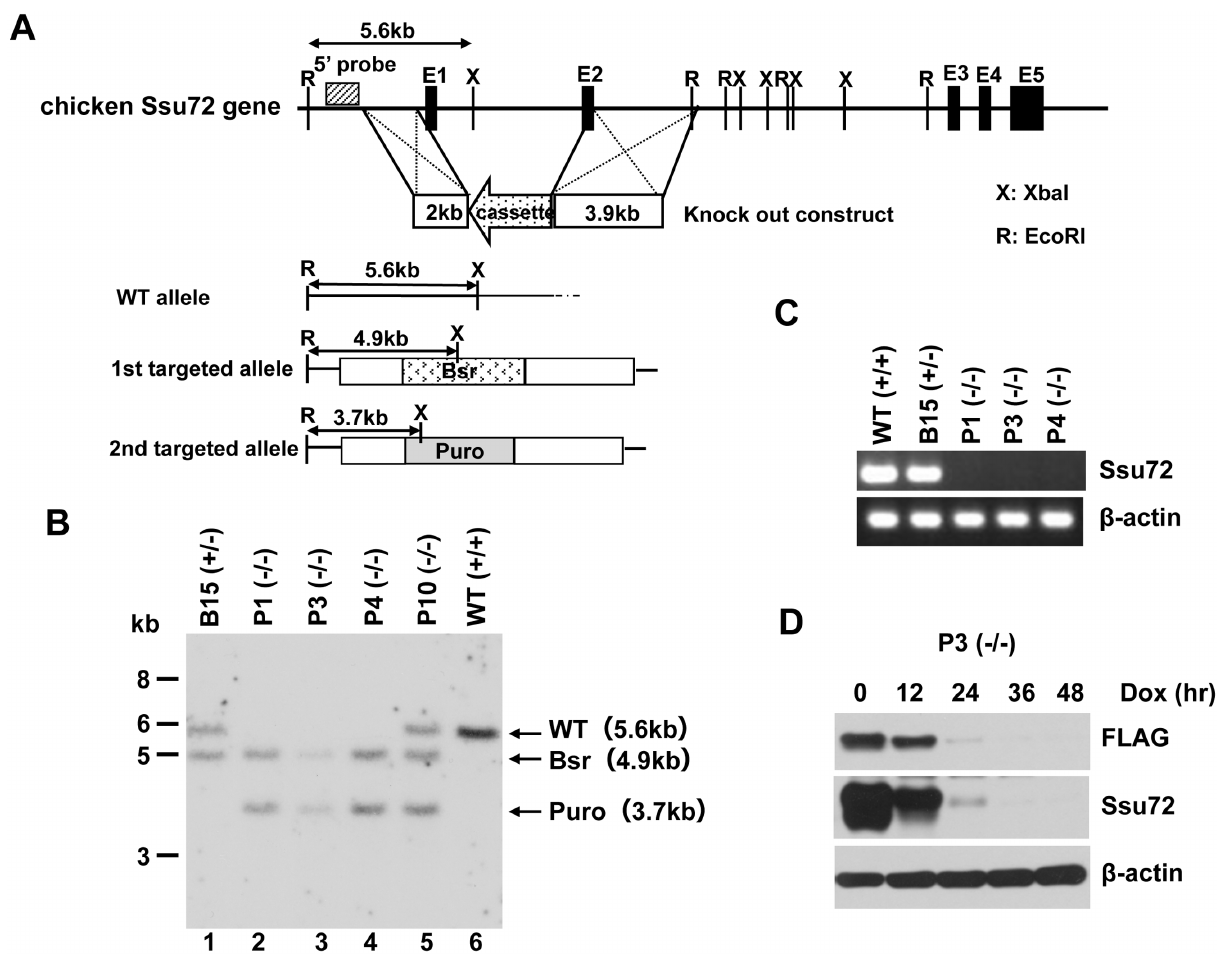
Figure 1. Establishment of conditional Ssu72-knockout DT40 cell lines. (A) Schematic representations of the chicken Ssu72 genomic fragment, knockout constructs, and configuration of the targeted alleles. Exons are shown as black boxes (E1–5), and the location of the 5 9 probe used for Southern blotting is shown as a grey box. The double-headed arrows above the genes indicate length (in nucleotides). The XbaI and EcoRI restriction sites are indicated by vertical lines labeled X and R, respectively. (B) Southern blot analysis of wild-type (WT), heterozygous mutant (B15), homozygous mutant (P1, P2, P3), and unanticipated rearranged mutant (P10) clones. Genomic DNA obtained from each clone was digested with Xba I and Eco RI, and then hybridized with the 5 9 probe shown in panel A. (C) RT-PCR analysis of the wild-type and mutant clones using primer pairs specific for the indicated gene. (D) Immunoblotting analysis of DT40 P3 ( 2 / 2 ) whole-cell extracts treated with Dox for the indicated times, using the indicated antibodies. Western blotting of b -actin was used as to confirm equal protein loading.